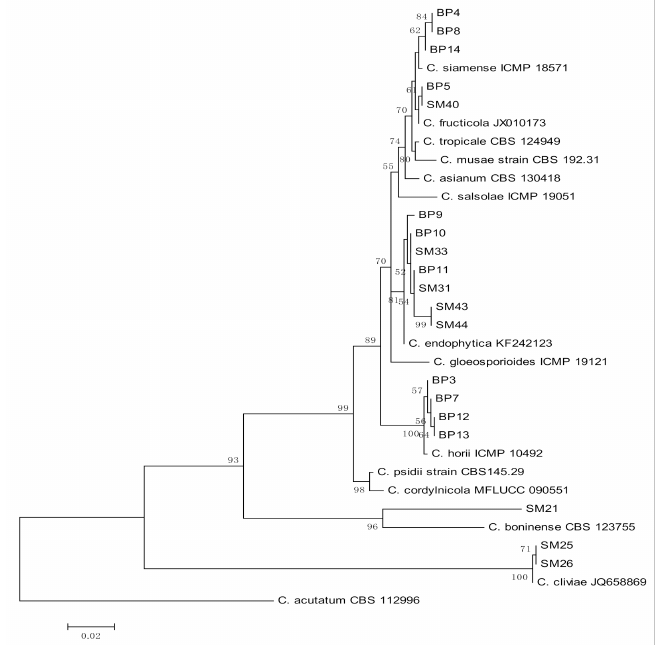
Figure 2. Maximum likelihood tree inferred from combined sequences of internal transcribed spacer (ITS) and GAPDH of Colletotrichum isolates from C. castaneus spines with bootstrap values higher than 50% are shown next to the branches.